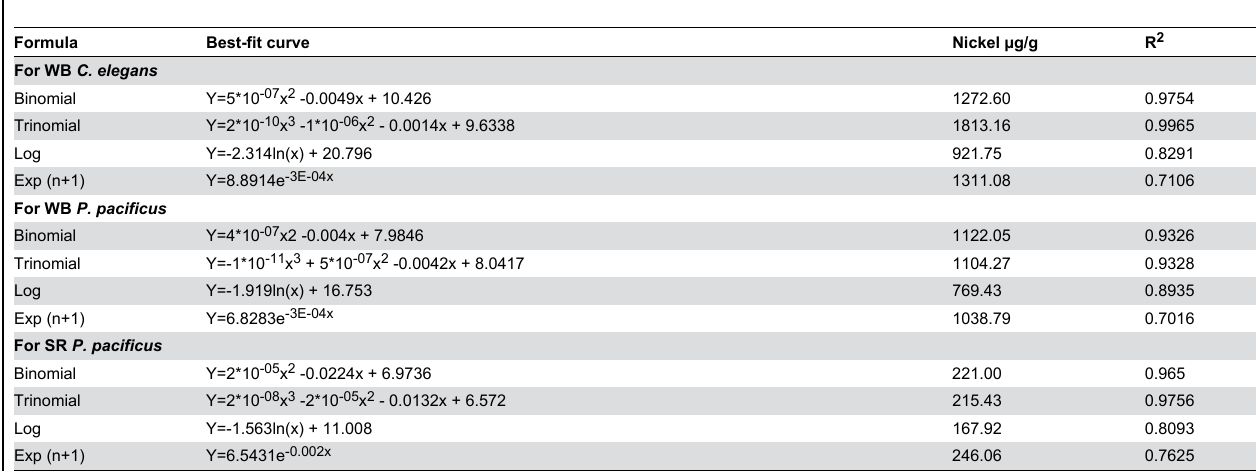
Table 5. Best fit curves for survivorship as a function of sediment nickel concentration.